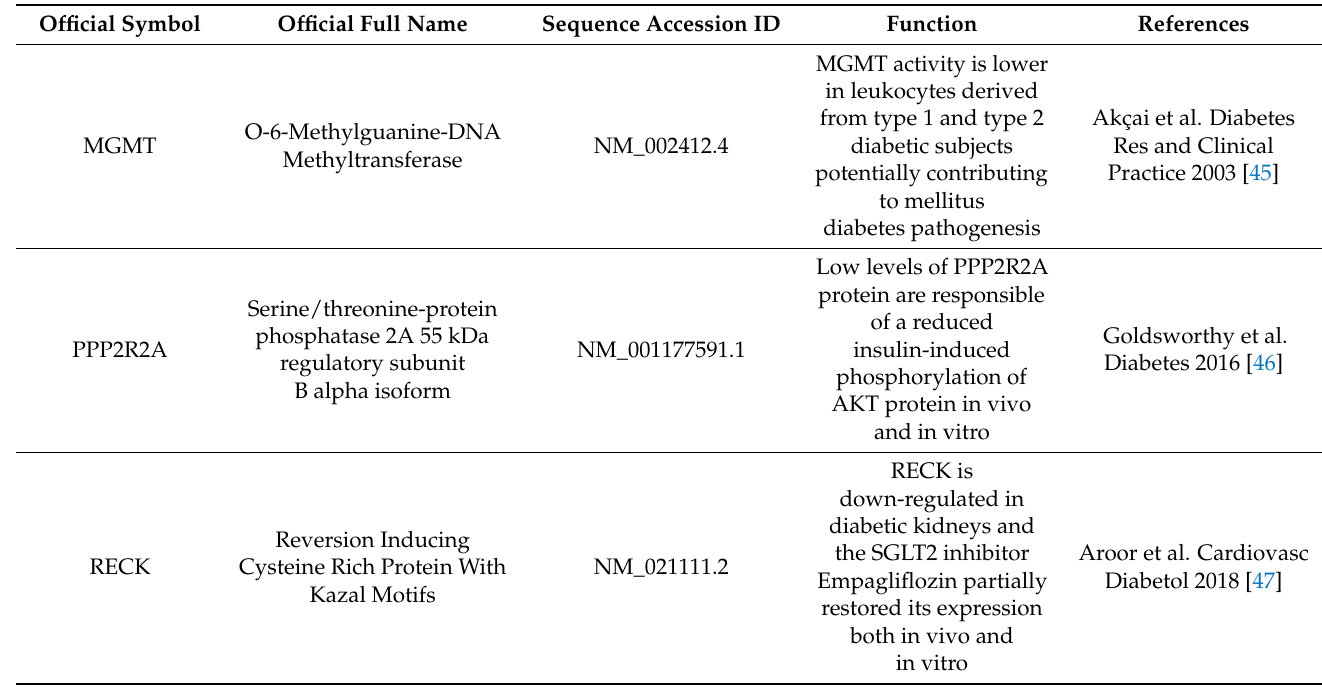
Table 4. Overview of the three common miR-222-3p and miR-409-3p validated target genes with a role in T2D.